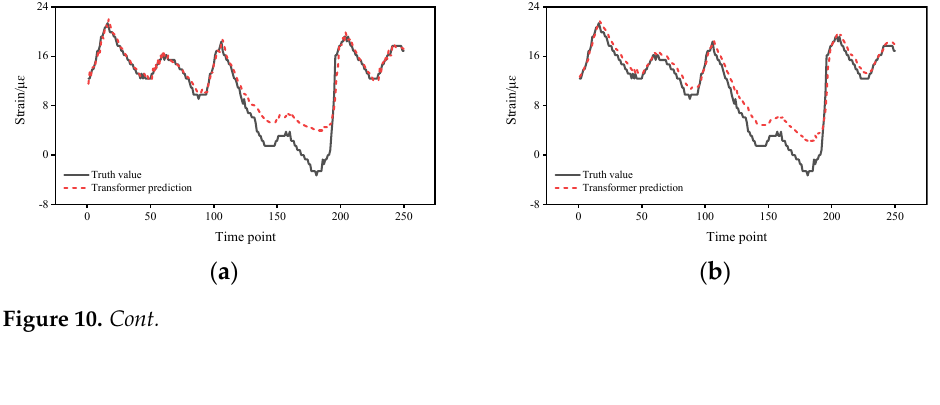
( h ) Figure 10. The prediction results of Transformer and LSTM when the input points are 3 points: ( a ) Transformer prediction for S01. ( b ) LSTM prediction for S01. ( c ) Transformer prediction for S02. ( d ) LSTM prediction for S02. ( e ) Transformer prediction for S03. ( f ) LSTM prediction for S03. ( g ) Trans- former prediction for S09. ( h ) LSTM prediction for S09. 7. Conclusions In this paper, a Transformer-based time series prediction framework is proposed for predicting the structural response of bridges with time dependence. The proposed frame- work contains multiple encoder modules and attention modules, and this structure en- hances the semantic recognition of the temporal series data and is more conducive to ex- tracting the features of the structural response. The accuracy of the proposed framework is verified by six-month strain response data of a concrete bridge. The proposed frame- work is compared with the most commonly used LSTM-based structural response predic- tion framework, and the results is shown as follows: